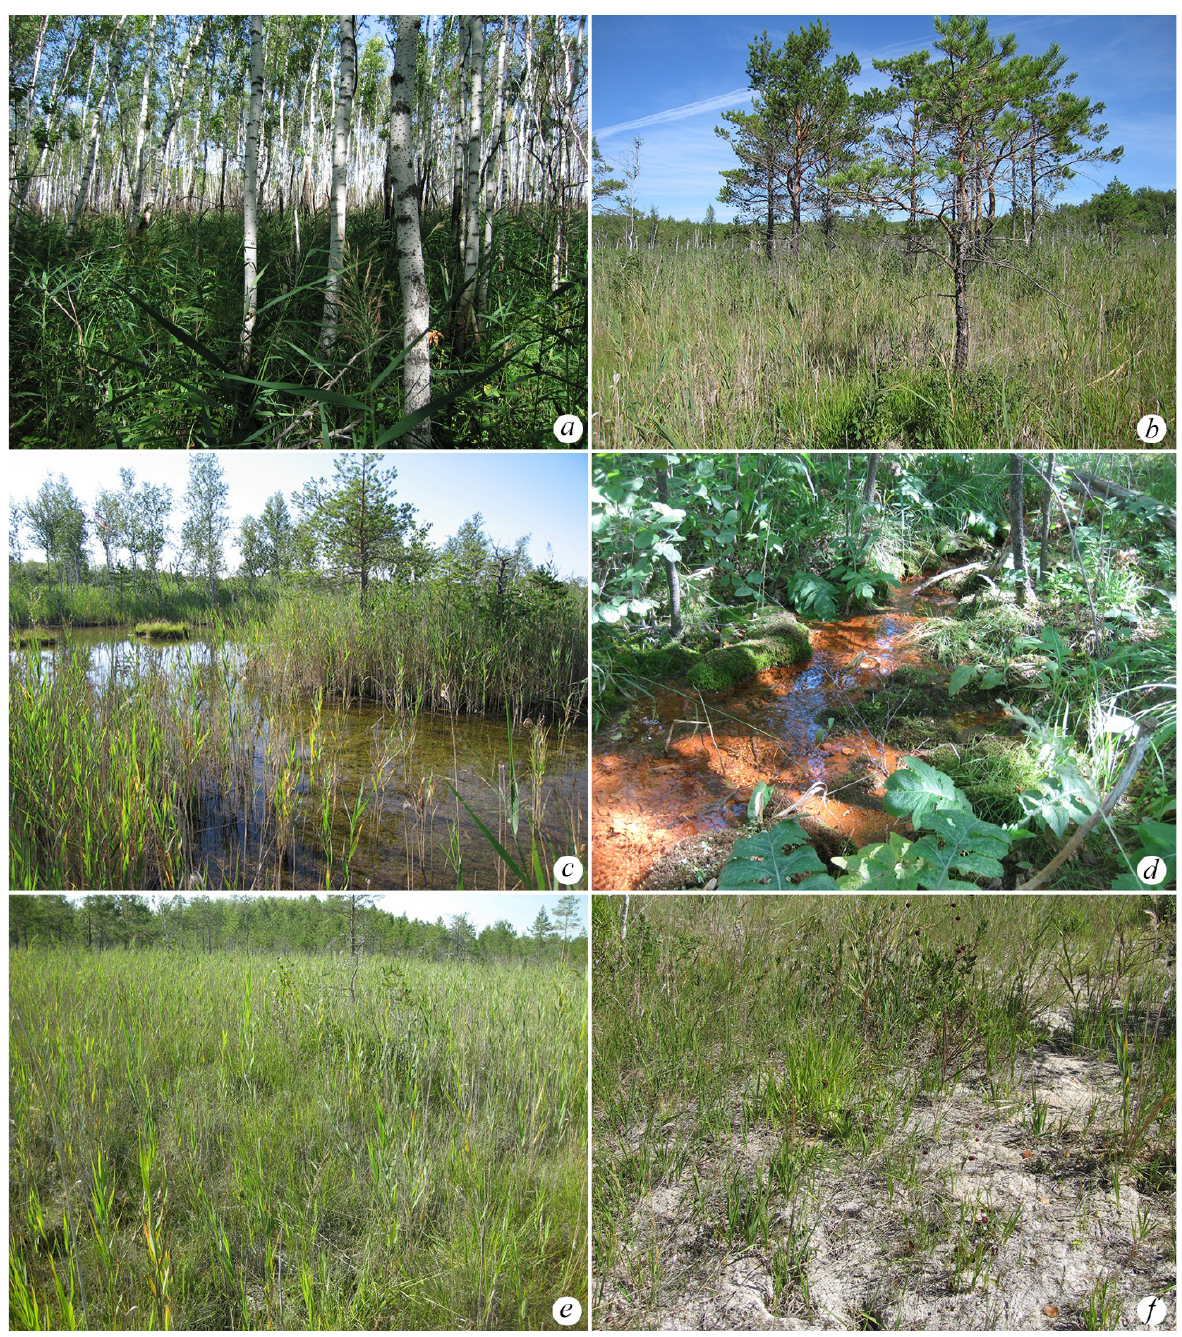
Figure 2. Plant communities and habitats described in the text. a: sedge - reed birch and birch - alder forested mire; b: sparse pine and birch forested mire; c: pool with large hummocks forming islands; d: stream; e: Schoenus ferrugineus - small sedges - brown mosses open mire; f: lime deposit covering the mire surface. Grigoriev in Martynenko et al . 2003 from the alliance Betulion pubescentis Lohmeyer et